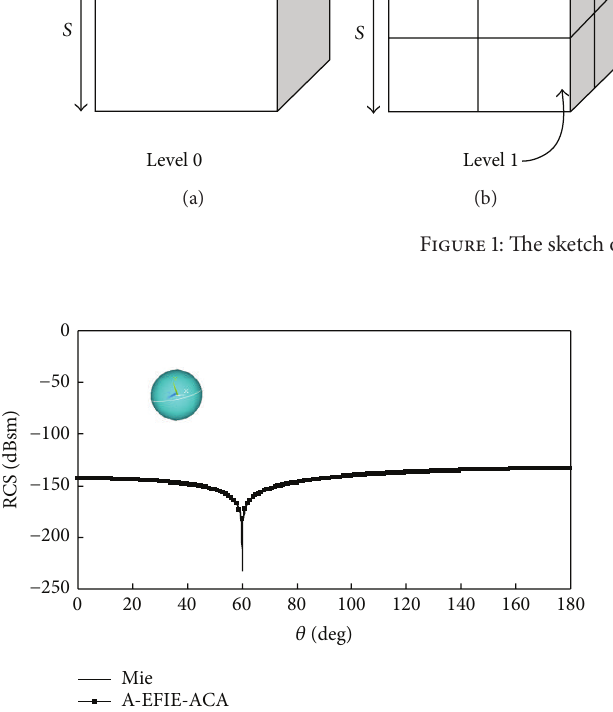
Figure 2: The VV-polarization bistatic RCS for PEC sphere at 150KHz.